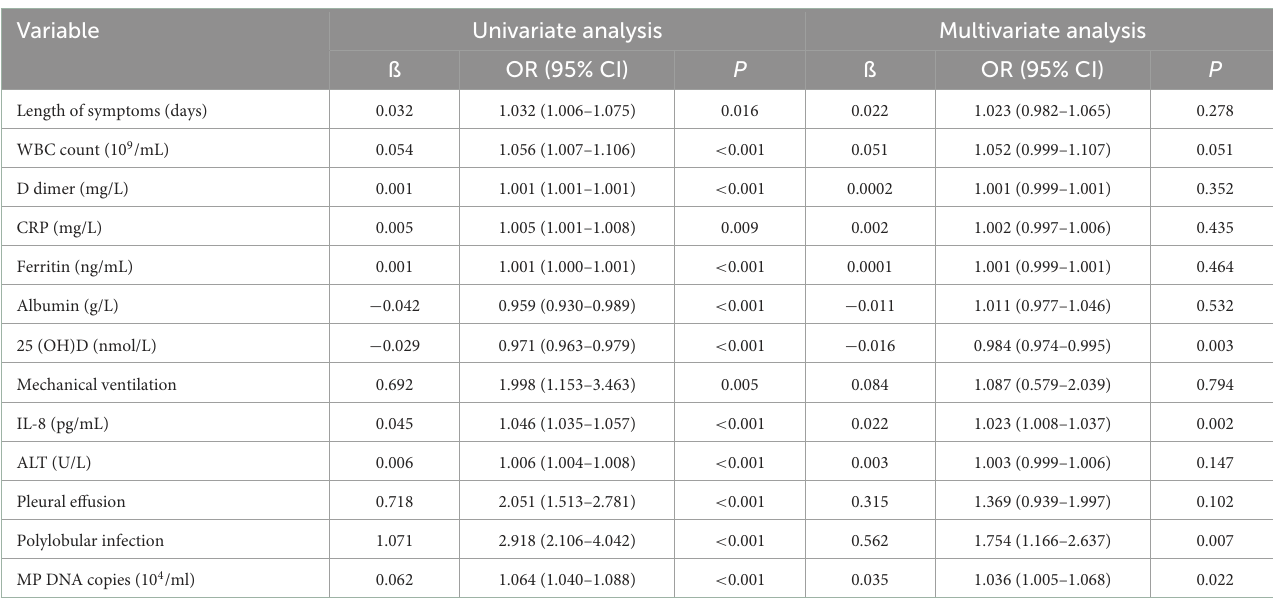
TABLE 3 Logistic regression analysis of clinical characteristics associated with